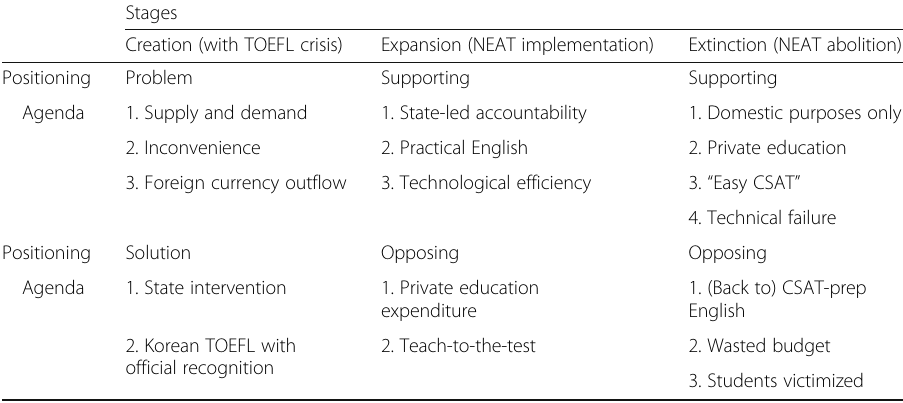
Table 2 Description of how NEAT texts were selected and